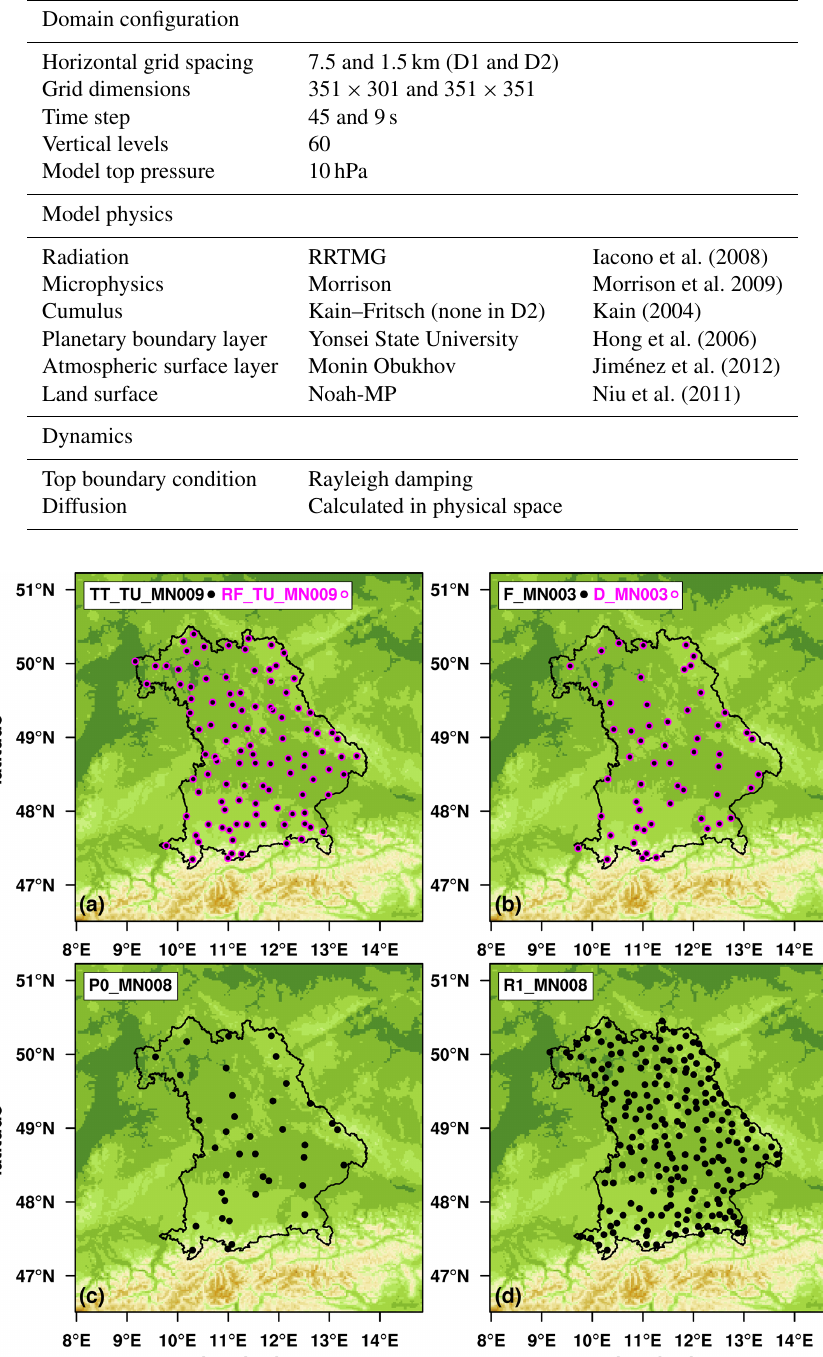
Table 1. Summary of the WRF configuration used for BAYWRF. A full sample namelist is provided in Appendix A.